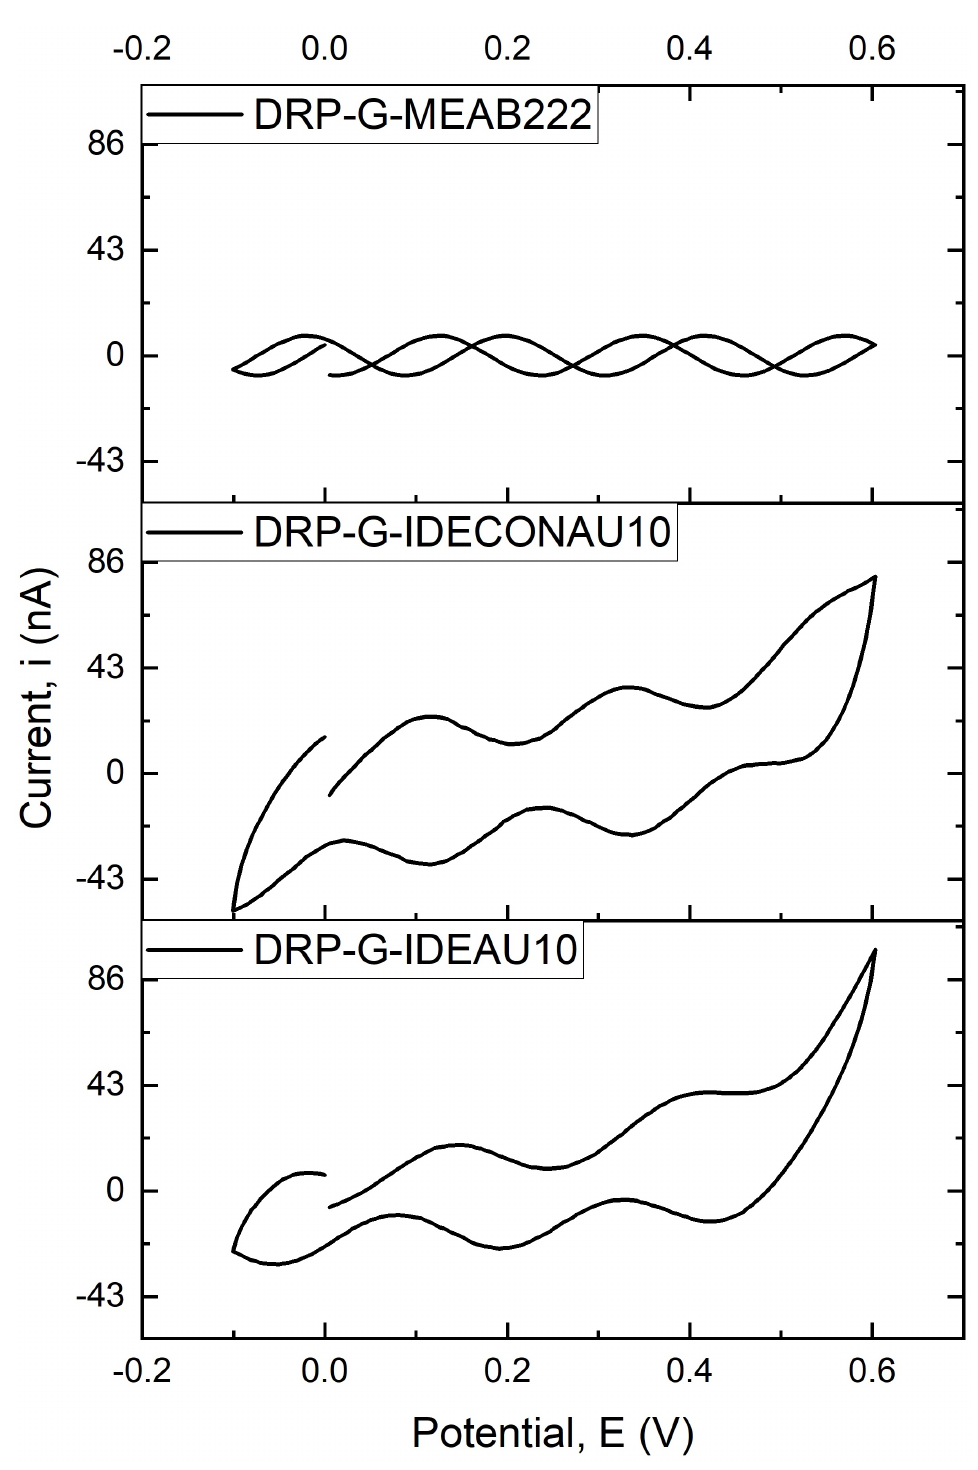
Figure 2. Cyclic voltammogram (CV) of three different electrodes using analyte